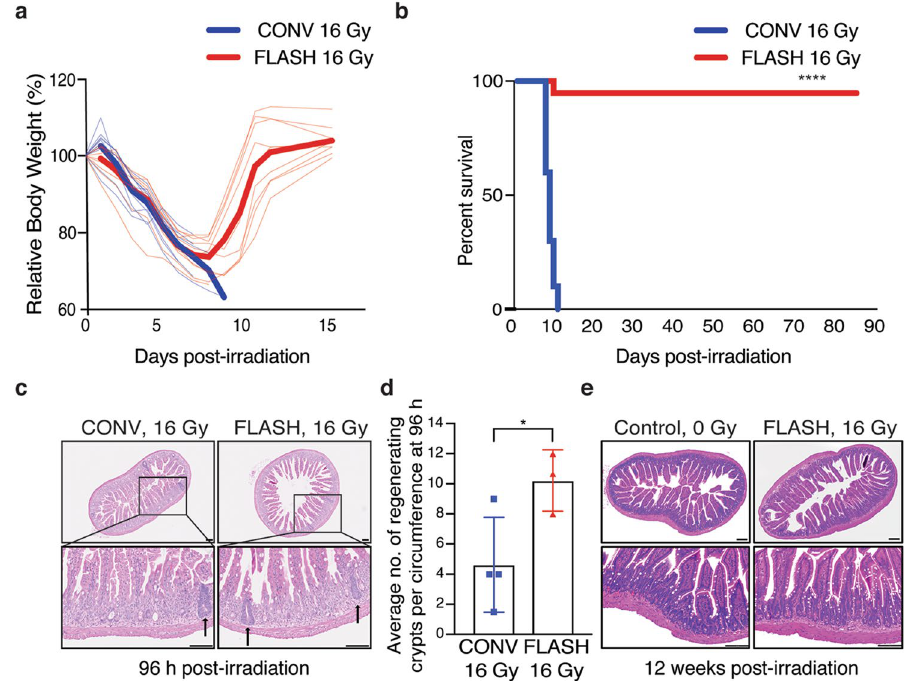
Figure 2. Abdominal FLASH irradiation produces less lethality from radiation-induced gastrointestinal syndrome than CONV irradiation in non-tumor bearing mice. ( a ) Relative percent body weight (%) of each mouse over time after 16 Gy CONV or FLASH TAI; bold lines represent the averages for the cohorts. ( b ) Kaplan–Meier survival curve of animals that received 16 Gy total abdominal irradiation (TAI), demonstrating complete lethality after CONV but near-complete survival after FLASH irradiation (n = 10 per group, **** by log-rank (Mantel-Cox) test p < 0.0001). ( c ) Histological images of hematoxylin and eosin (H&E) stained jejunal sections from animals 96 h after 16 Gy TAI. Arrows point to regenerating crypts. ( d ) Quantification of the average number of regenerating crypts per circumference 96 h post 16 Gy TAI, demonstrating over double the number of regenerating crypts after FLASH vs. CONV irradiation. Regenerating crypts were counted in 3 mid- jejunal circumferences per mouse (n = 4 mice in CONV; n = 3 in FLASH, *p < 0.05 by unpaired 2-tailed Student’s t-test). ( e ) Histological images of H&E stained jejunum cross-sections from unirradiated mice and surviving mice 12 weeks after 16 Gy FLASH TAI, demonstrating normal histology after recovery from FLASH. Scale bar: 100 μm. Error bars represent standard deviation of the